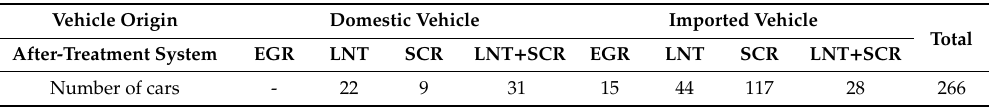
Table 2. Types of after-treatment system in certification vehicles. EGR—exhaust gas recirculation,